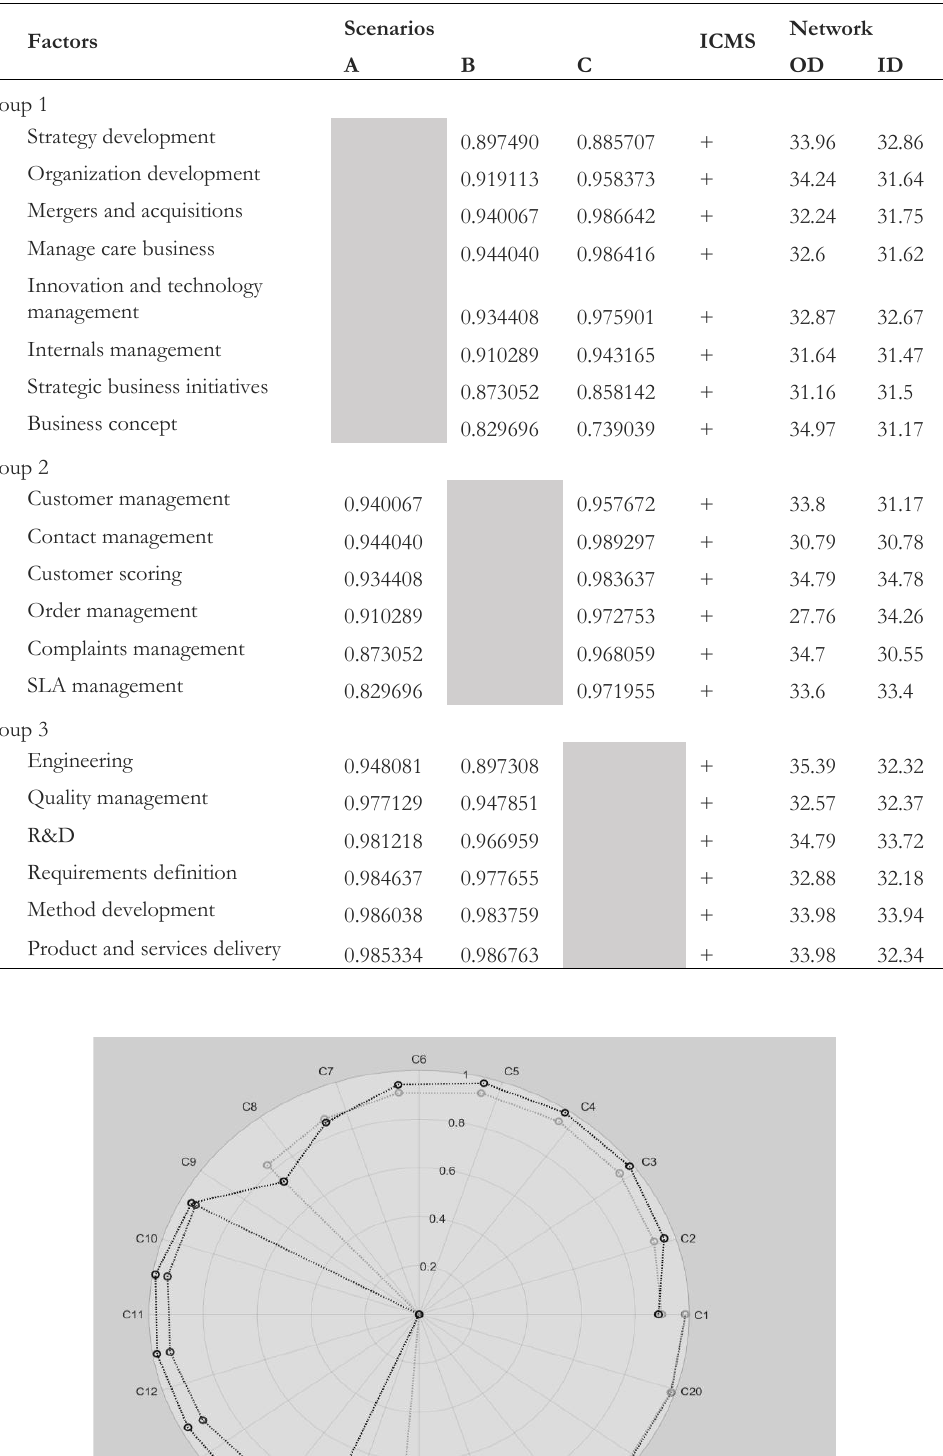
Table 5. Complete list of variables and main results of the FCM scenario and network analyses.